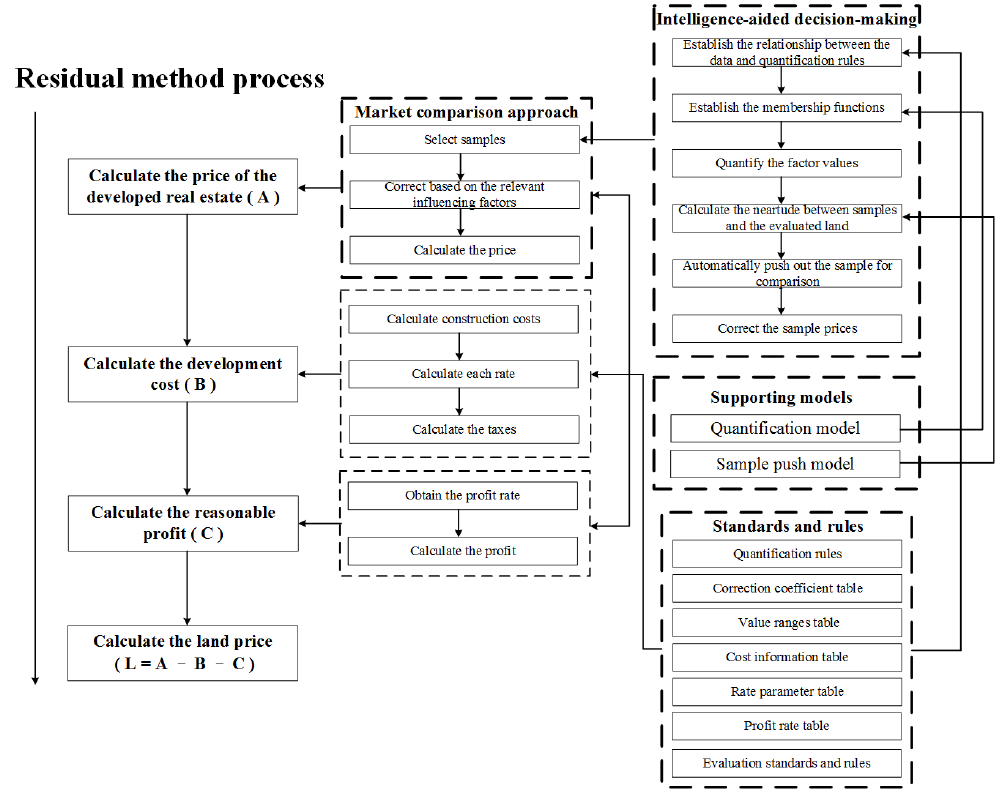
Figure 9. Evaluation process for the residual method supported by intelligence-aided decision-making.